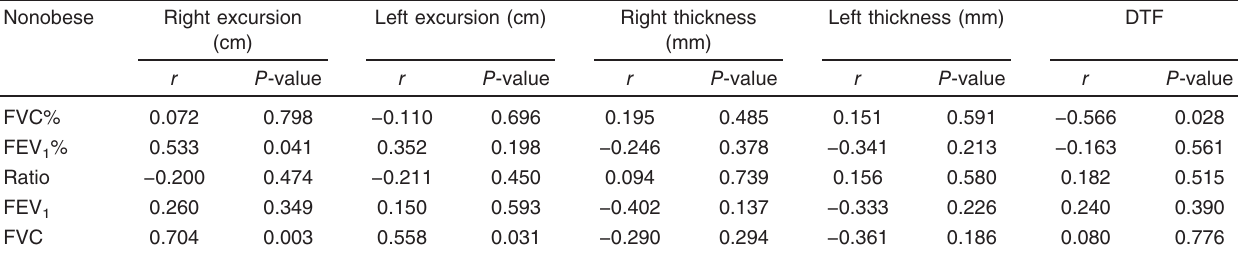
Table 10 Relation between spirometric parameters and ultrasound diaphragmatic parameters in nonobese persons Nonobese Right excursion Left excursion (cm)